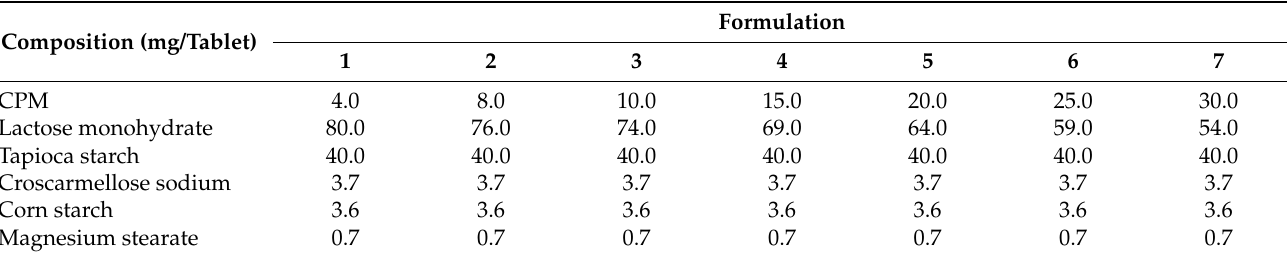
Table 5. Composition of chlorpheniramine maleate (CPM)